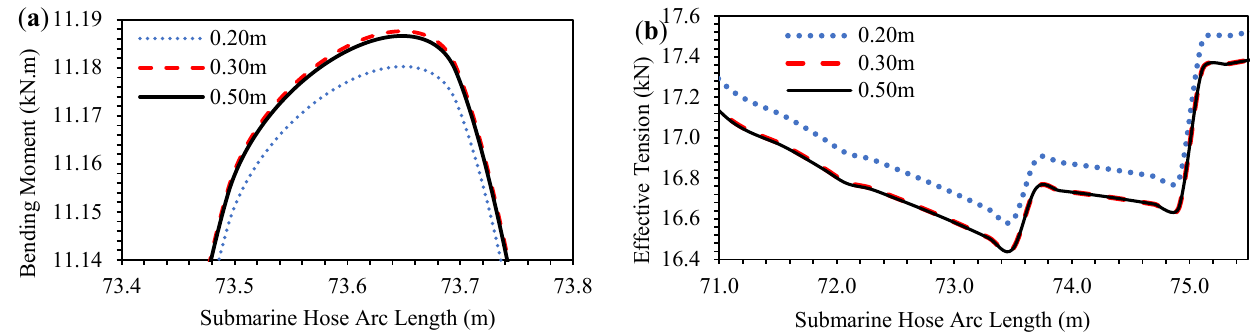
Figure 31. Effect of hose segment lengths of submarine hoses. ( a ) Bending Moment for hose segment lengths. ( b ) Effective tension for hose segment lengths.